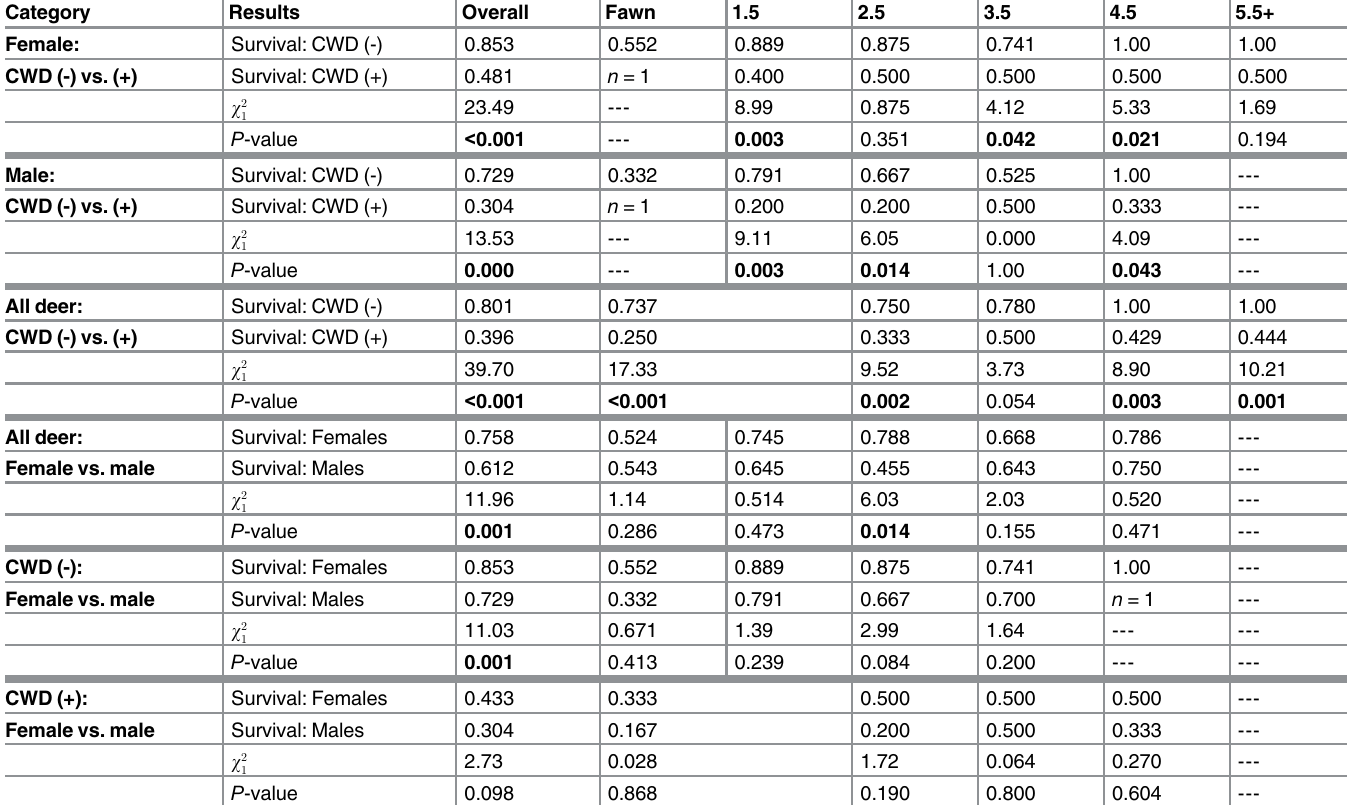
Table 1. Annual Survival Rate